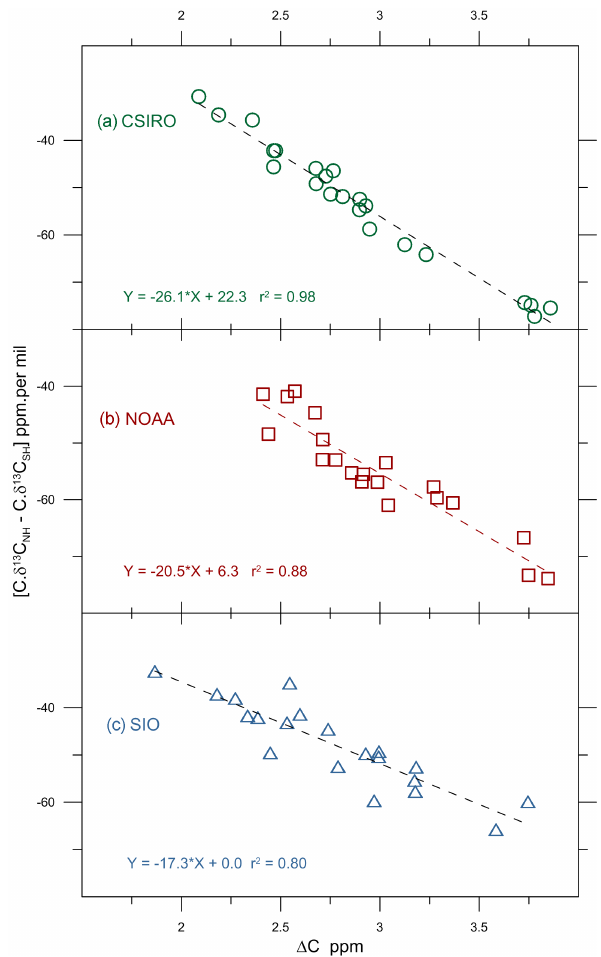
Figure 6. Isotopic evidence that interhemispheric CO 2 variations are systematic: the interhemispheric differences (cid:49) 13 CO 2 , repre- sented by (cid:49) (C × δ 13 C) plotted against (cid:49) 12 CO 2 for (a) CSIRO (mlo–cgo), (b) NOAA (mlo–cgo), and (c) SIO (mlo–spo) flask sam- ples since 1992. (One 2003 NOAA outlier (>5 σ) , is removed from these plots and regressions.) The linear regression coefficients and correlation coefficients ( r 2 ) are provided for each data